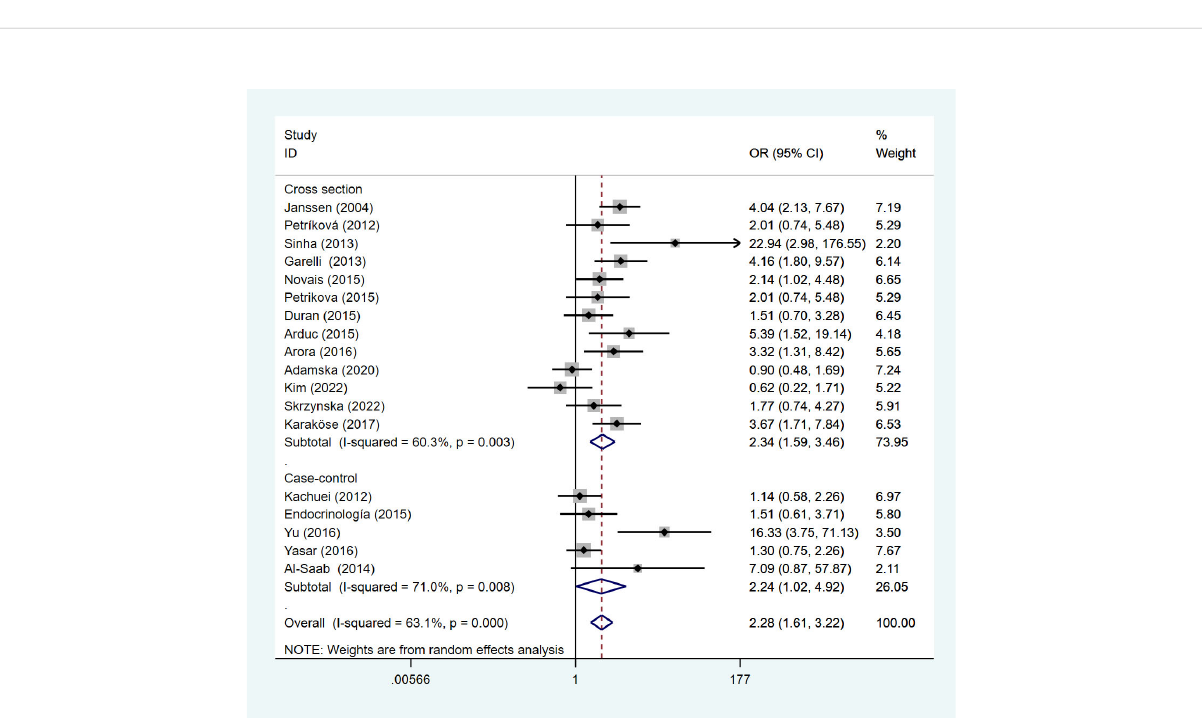
FIGURE 4 Forest plot for subgroup analysis of risk of HT in PCOS patients and non-PCOS patients by study type.